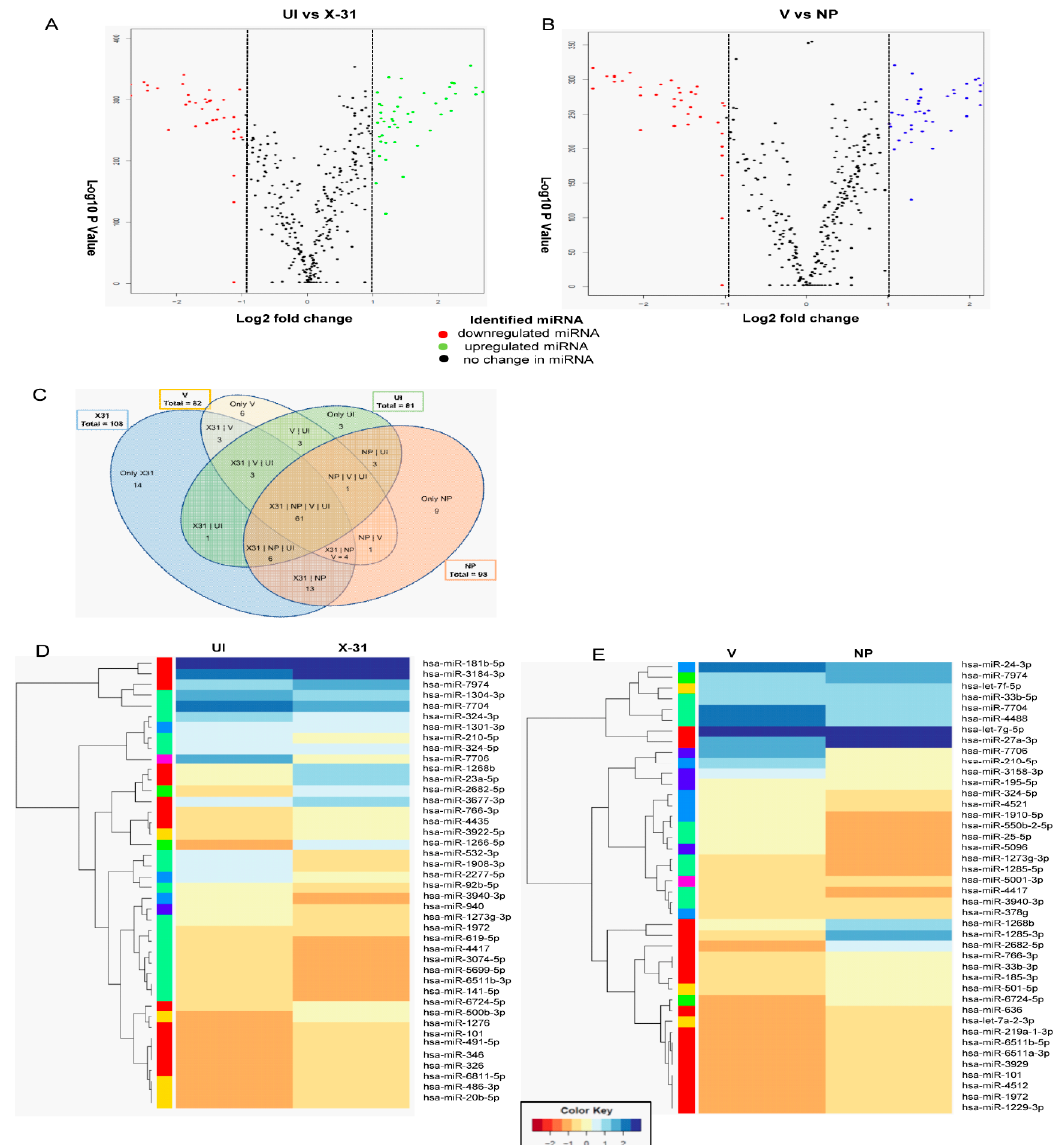
Figure 4. RNA sequencing identifies miRNAs involved in the regulation of the Akt/mTOR pathway. ( A and B ) The volcano plot represents the altered miRNAs in X-31 infected cells for 48 h at an MOI of 1 (SRR9688708 vs. SRR 9688709) and NP transfected 72 h sample (SRR9688707 vs. SRR9688706). miRNAs that were increased or decreased more than log2 FC (0.5) among the top 50 miRNAs are shown in green and red, respectively, whereas miRNAs with no significant change are shown in black. ( C ) This Venn diagram illustrates the numbers of miRNAs identified in each group and the number of common miRNAs within the four groups. ( D and E ) Heatmap showing the differential miRNA expression in A549 cells infected with X-31 for 48 h relative to mock-infected and NP transfected A549 cells for 72 h vs. the control cells were plotted using R package. miRNAs significantly changed ( > two-fold) are colored in blue and red for upregulated and downregulated, respectively.